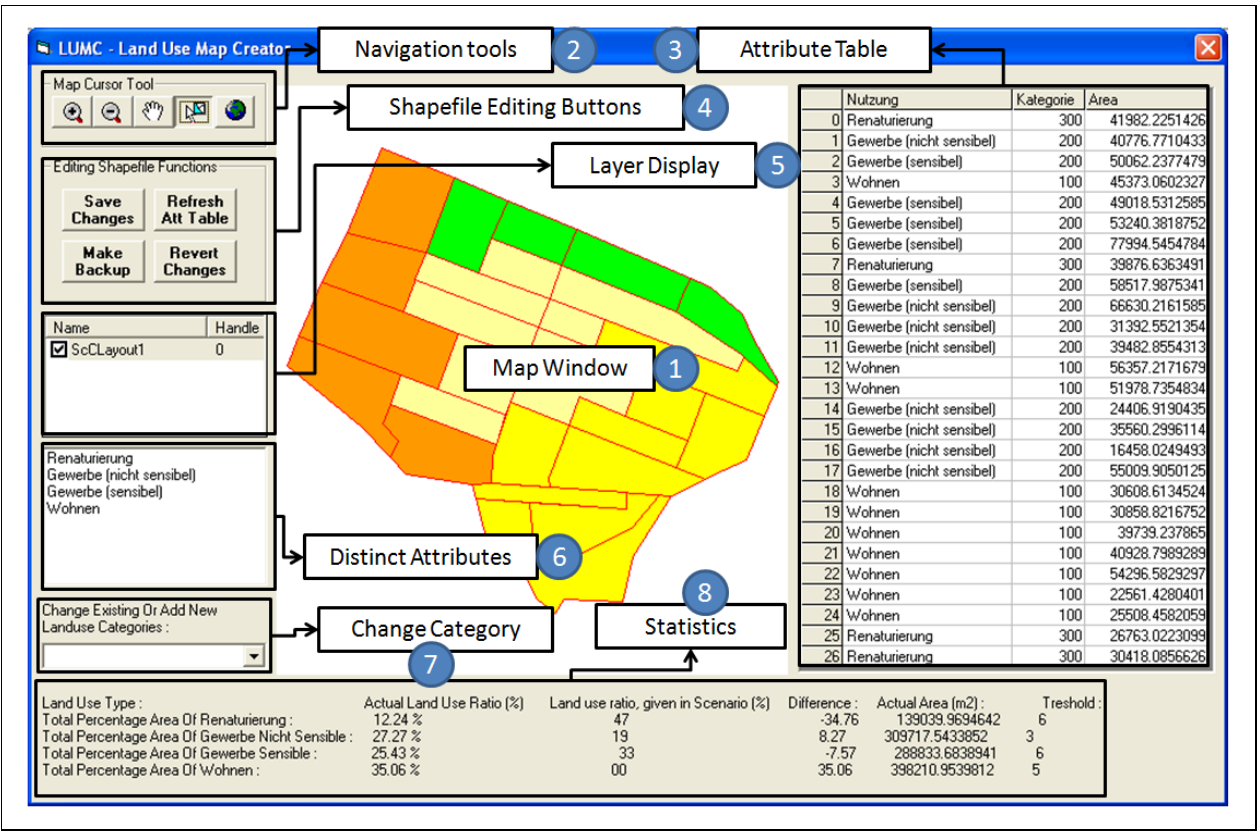
Figure 1 : Standalone application developed uising MapWinGIS and VB6 for integration into